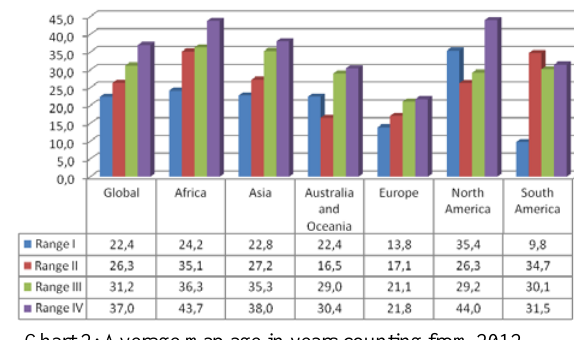
Chart 2: Average map age in years counting from 2012